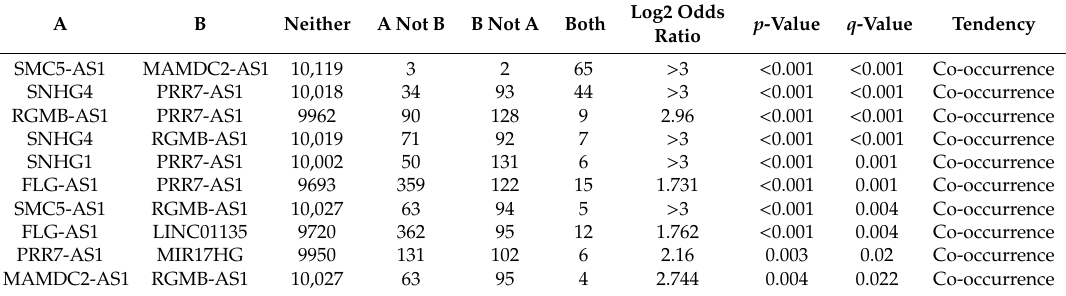
Figure 4. Co-expression between olaparib-targeted poly-(ADP-ribose) polymerases (PARP) and olaparib-modulated lncRNAs. Co-expression between PARP1/2 and olaparib-modulated lncRNAs in the uveal melanoma cohort from The Cancer Genome Atlas (TCGA), obtained from cBioPortal. Graphs show a significant correlation ( q -value < 0.05) between ( A ) mRNA expression of SNHG1 and mRNA expression of PARP1; ( B ) mRNA expression of SNHG1 and mRNA expression of PARP2; ( C ) mRNA expression of SNHG4 and mRNA expression of PARP2; ( D ) mRNA expression of MIR17HG and mRNA expression of PARP2. Table 1. Mutual exclusivity of alterations in olaparib-modulated lncRNAs in the PanCancer Atlas cohort from cBioPortal, showing how alterations in some of these lncRNAs tend to